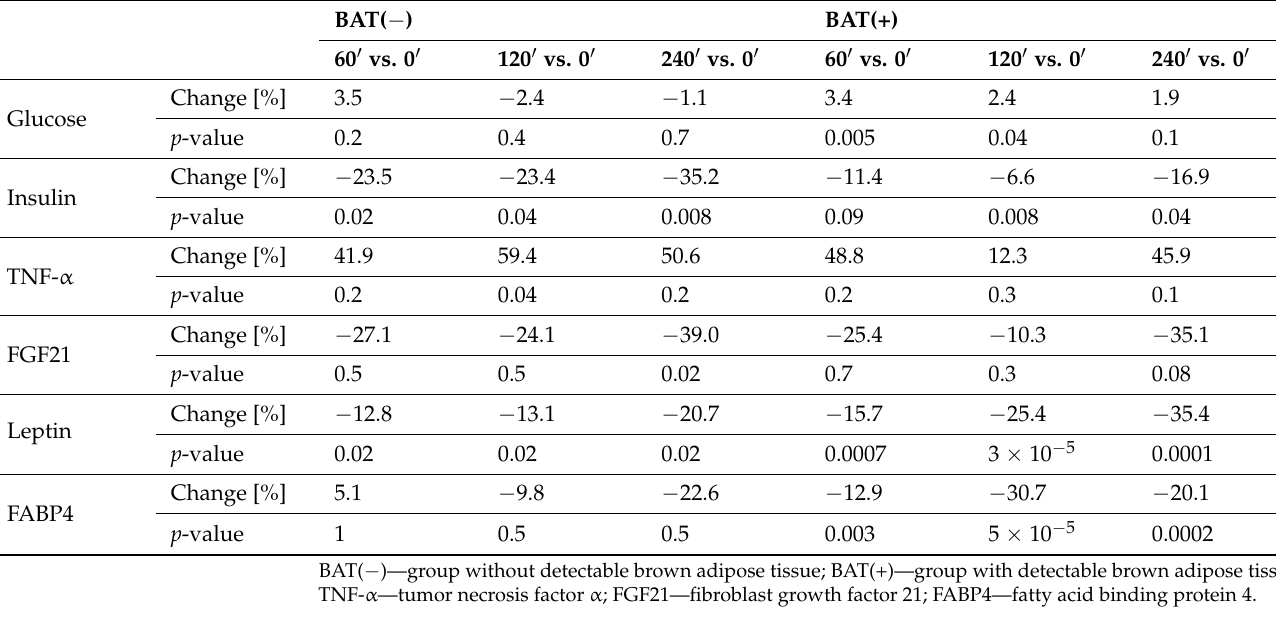
Table 3. Median percentage of change and p -value of Wilcoxon signed-rank test.